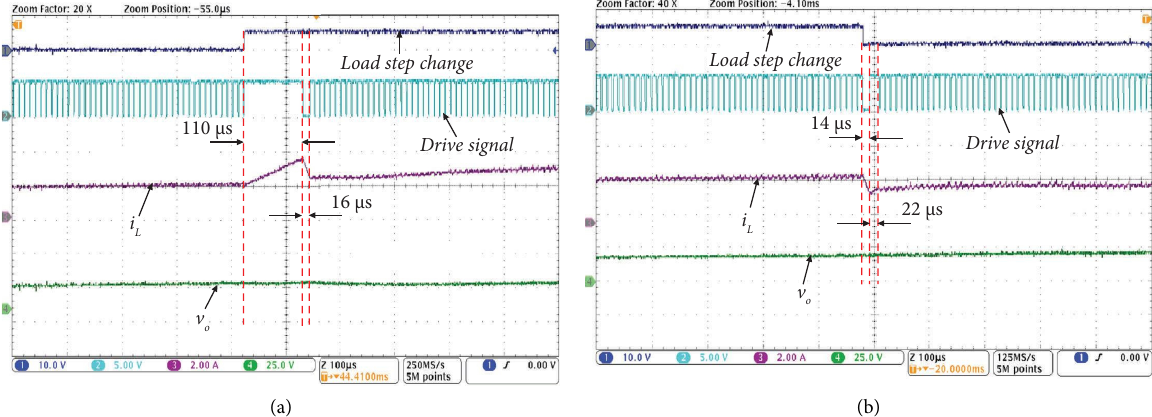
Figure 16: Transient waveforms of the proposed controller at π /3. (a) Step change of i 3.5A to 2.2A.